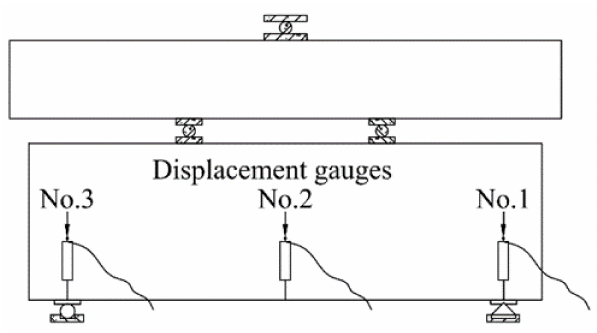
Figure 8. Distribution of meter